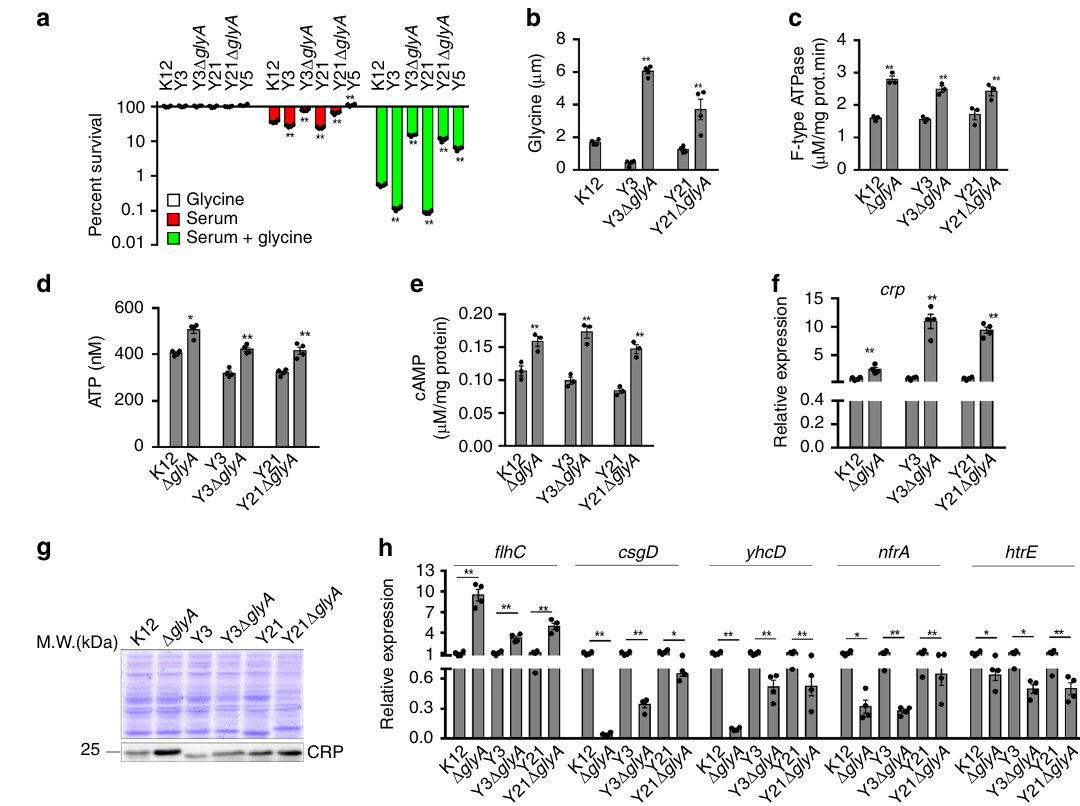
Fig. 8 Effect of glyA deletion on glycine-cAMP/CRP-YhcD/NfrA/HtrE pathway. a , b Percent survival ( a ) and intracellular glycine ( b ) of E. coli Y3 and Y21 and their glyA -deleted mutants Y3 △ glyA and Y21 △ glyA , respectively. E. coli K12 and serum-resistant Y15 were used as negative and positive controls, respectively ( n = 4). c – e ATP synthase activity ( c ), ATP level ( d ), and cAMP level ( e ) in the indicated strains ( c , e , n = 3; d , n = 4). f crp expression in the absence of glyA ( n = 4). g CRP expression in the absence of glyA . h qRT-PCR for expression of fl hC , csgD , yhcD , nfrA , and htrE in the absence of glyA ( n = 3). Results are displayed as mean ± SEM ( a – f , g ), and signi fi cant differences are identi fi ed (* p < 0.05, ** p < 0.01) as determined by two-tailed Student ’ s t